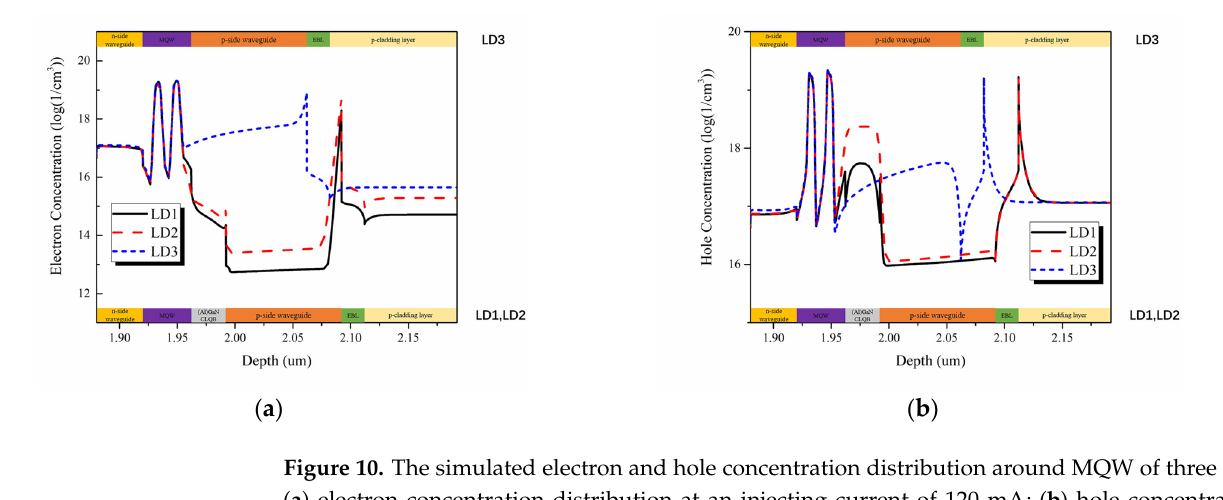
Figure 9. Band energy diagram of LD1 and hole/electron current density around MQW of three LDs. ( a ) Band energy diagram of LD1 at an injecting current of 120 mA where the dashed lines represent electron and hole Fermi levels; ( b ) Hole current distribution around the MQW regions at the vertical direction of three LDs; ( c ) Electron current distribution around the MQW regions at the vertical direction of three LDs.